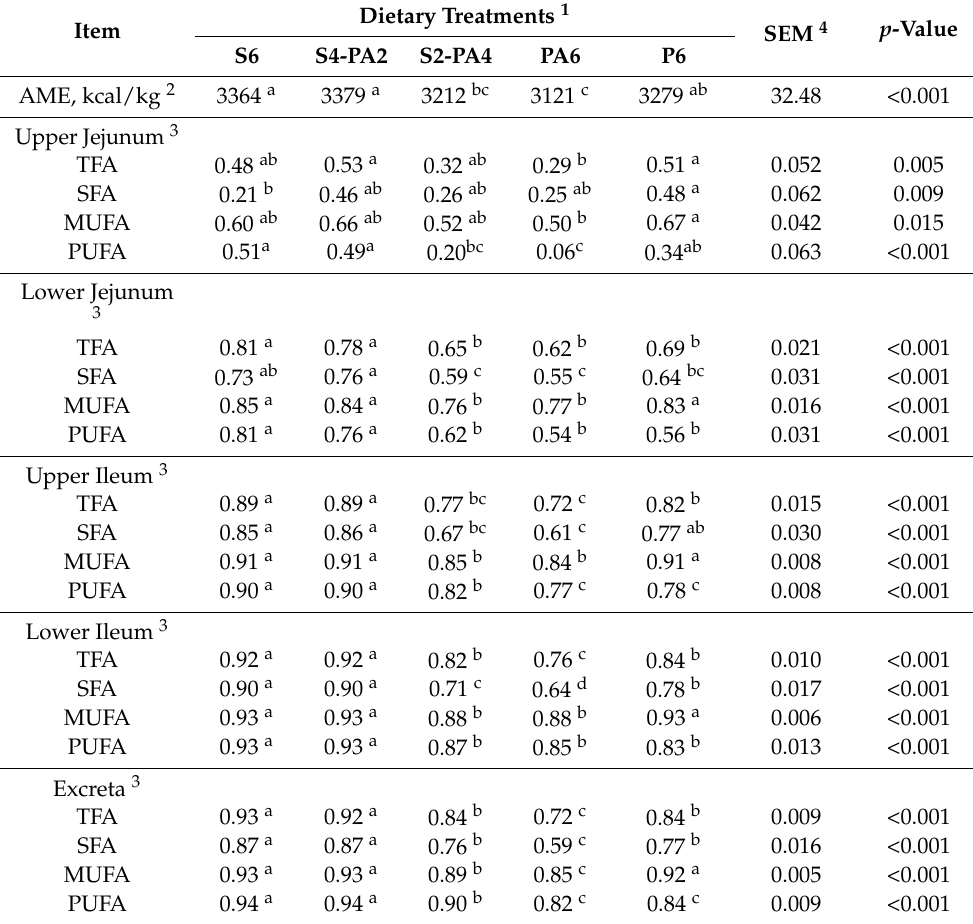
Table 8. Feed apparent metabolizable energy values and apparent fatty-acid digestibility coefficients along the intestinal tract and excreta according to different fat sources in the diet in 35-d-old broiler